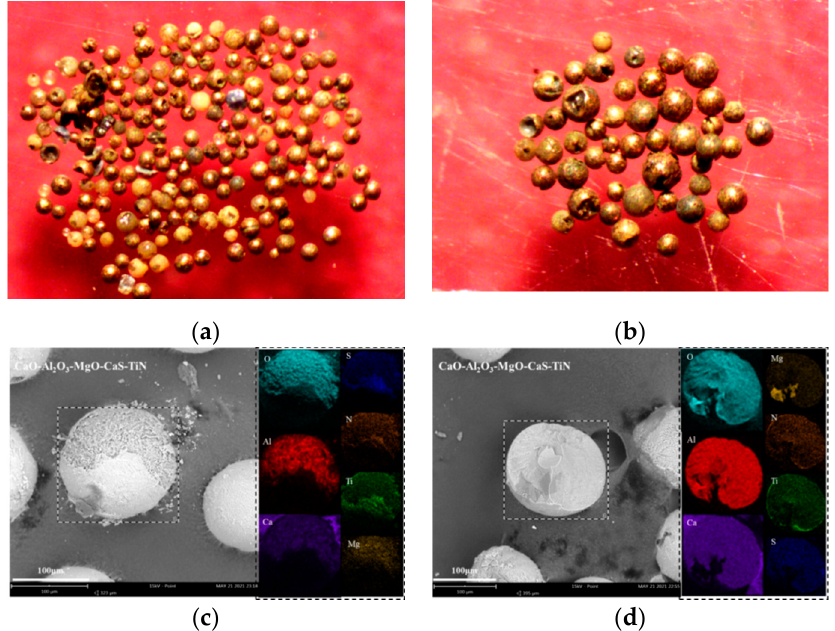
Figure 4. The surface morphology and EDS analyses acquired from a big simple electrolytic inclusion sample: ( a , b ) 20× OM image; ( c ) SEM surface morphology image with EDS elemental mapping analysis; ( d ) SEM surface morphology image of fracture surface of an inclusion with EDS elemental mapping analysis.